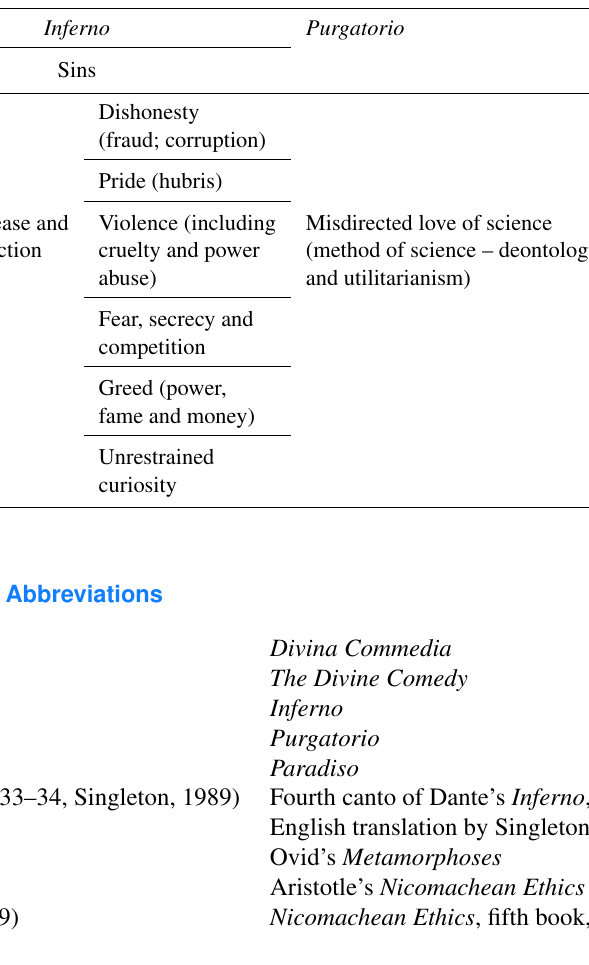
Table A1. Structure of the